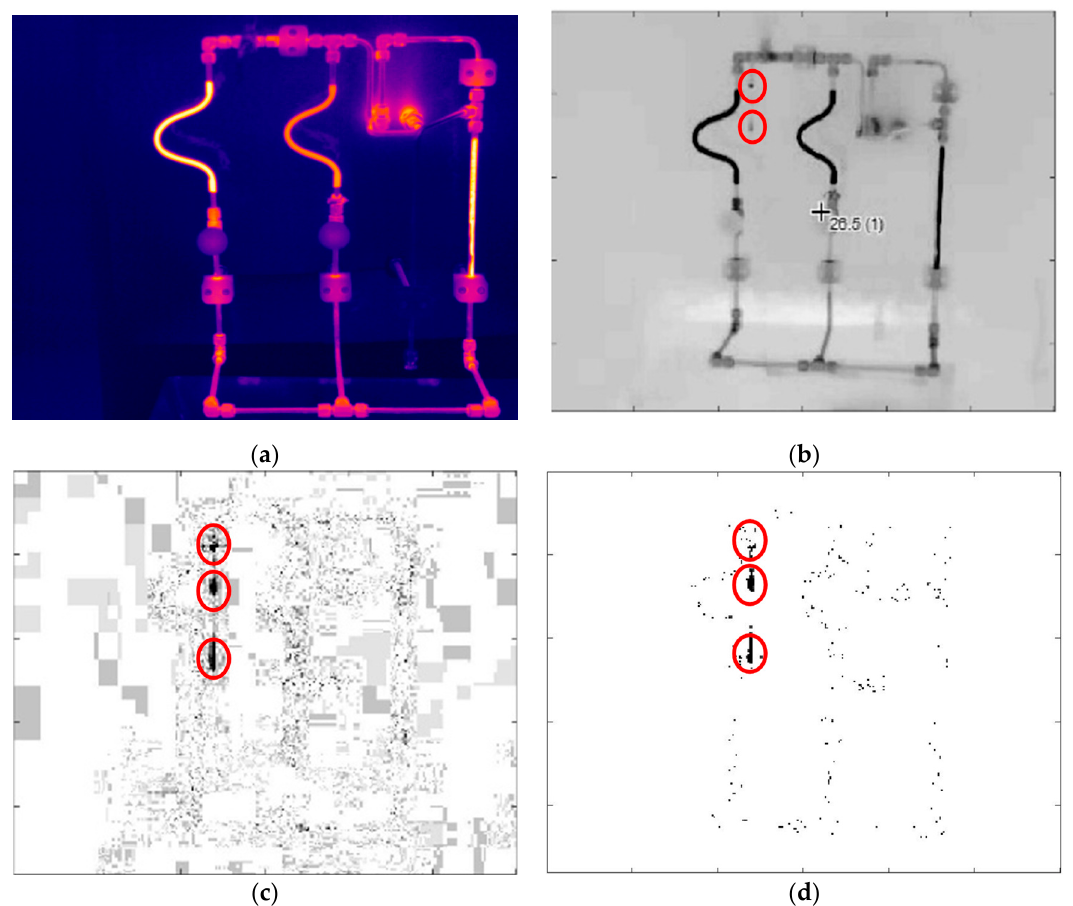
Figure 1. ( a ) Raw infrared image of the demonstrator plant used in this experience. ( b ) Sample frame of the demonstrator plant with leakage resulting from the MP4 format in gray scale. ( c ) Subtracted frame resulting from subtracting subsequent frames. ( d ) Subtracted frame after background noise removal. After background noise removal, the noise along the pipes still remains. Leaking drops are marked with solid line circles.